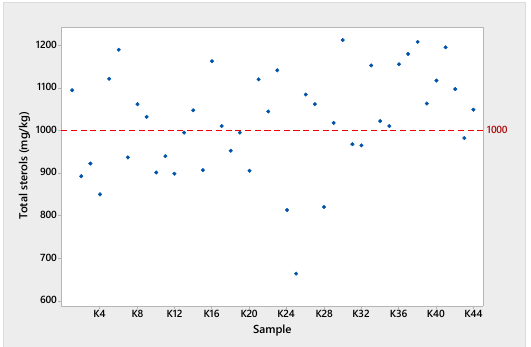
Figure 1. Diagram illustrating total sterols parameter (40.9% of Koroneiki olive oil samples are below the set limit of 1000 mg/kg). Dotted line represents the limit according to EEC/2568/91 for the EVOO category. Table 3. Sterol profile of the examined monocultivar olive oils in the coastline region of Western Greece. cv. Koroneiki cv. Lianolia Calculating EEC Limit for p -Value ( N = 44) Kerkyras ( N = 60) EVOO Category Sterols and Triterpene Diols Cholesterol